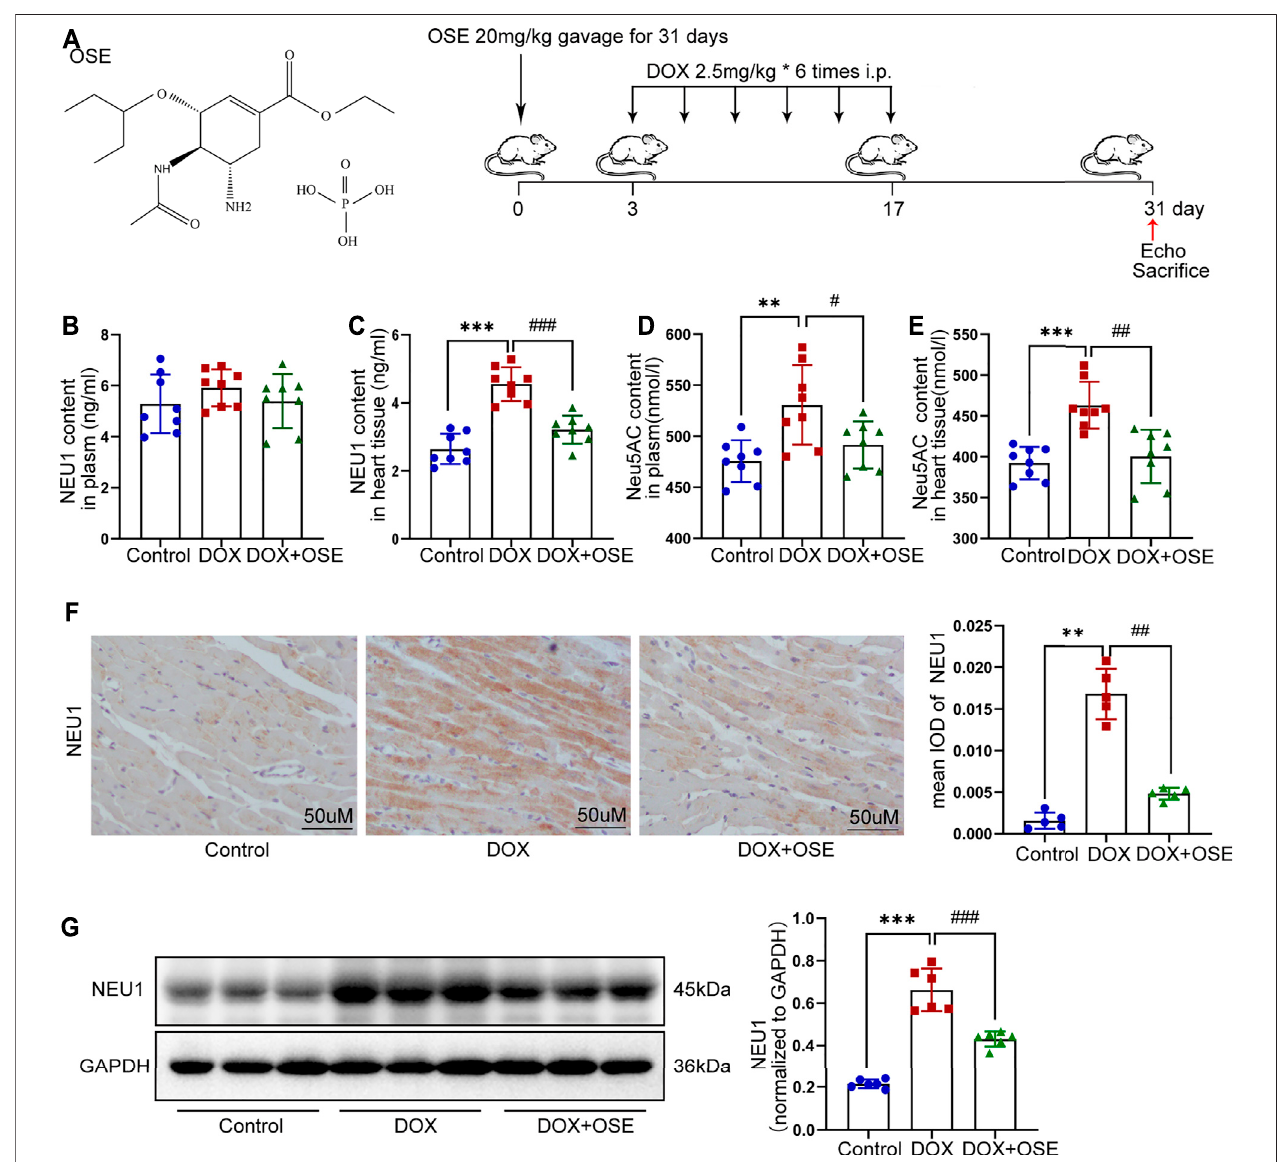
FIGURE 1 | Doxorubicin (DOX) exposure resulted in elevated neuraminidase 1 (NEU1) activity and expression in adult rats. (A) The chemical structure of NEU1 inhibitor oseltamivir (OSE) and the schematic diagram of this study. (B – E) The content of NEU1 and its regulated downstream metabolite N-acetylneuraminic acid (Neu5AC) in animal plasma or heart tissue measured by commercial ELISA assays ( n (cid:1) 8 per group). (F) Representative immunohistochemical images of NEU1 expression in rat hearts ( n (cid:1) 5 per group, scale bar (cid:1) 50 μ m). (G) The expression of NEU1 in rat hearts analyzed by western blot ( n (cid:1) 6 per group). (** p < 0.01 vs. control group, *** p < 0.001 vs. control group. # p < 0.05 vs. DOX group, ## p < 0.01 vs. DOX group, ### p < 0.001 vs. DOX group).